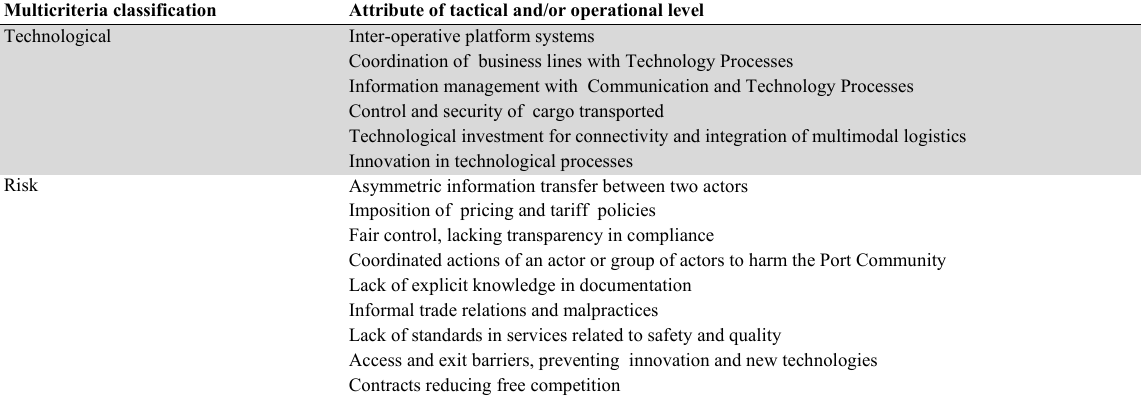
Fig. 2. Relationships at corporate, tactical and operational levels Classification of causes or attributes at tactical and operational levels, generating technological and risk criteria in the port